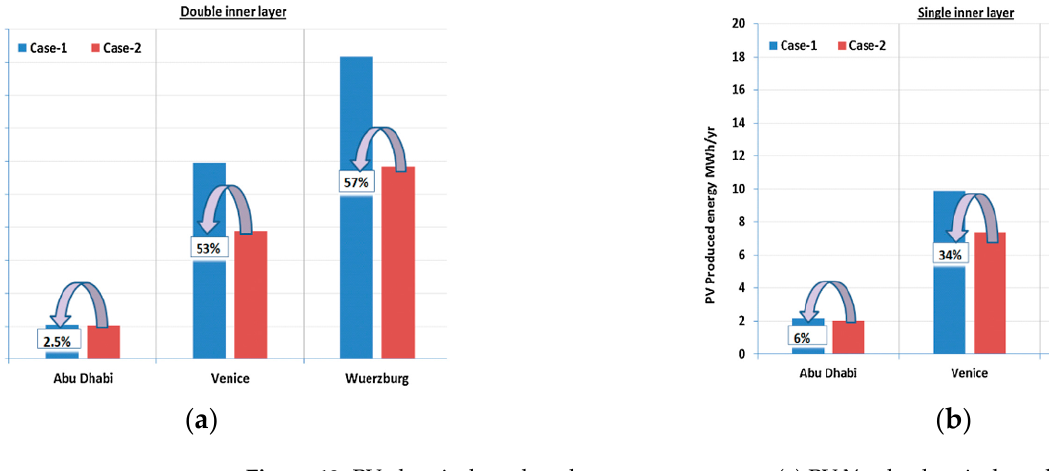
Figure 13 . PV electrical produced energy assessment: ( a ) PV Yearly electrical produced energy—DL; ( b ) PV Yearly electrical produced energy—SL (reprinted from [105]).